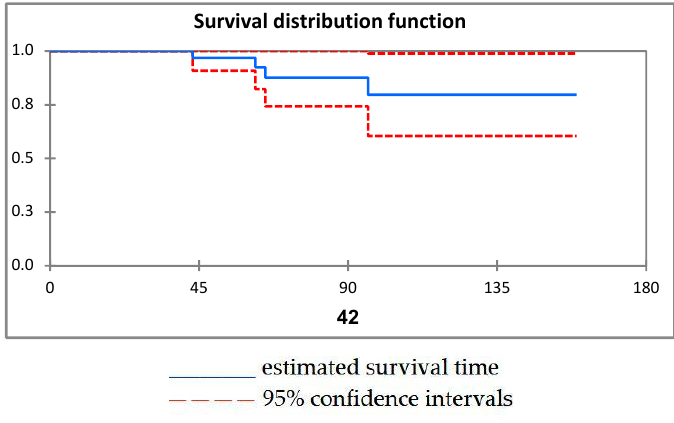
Figure 2. Kaplan Meier survival analysis.